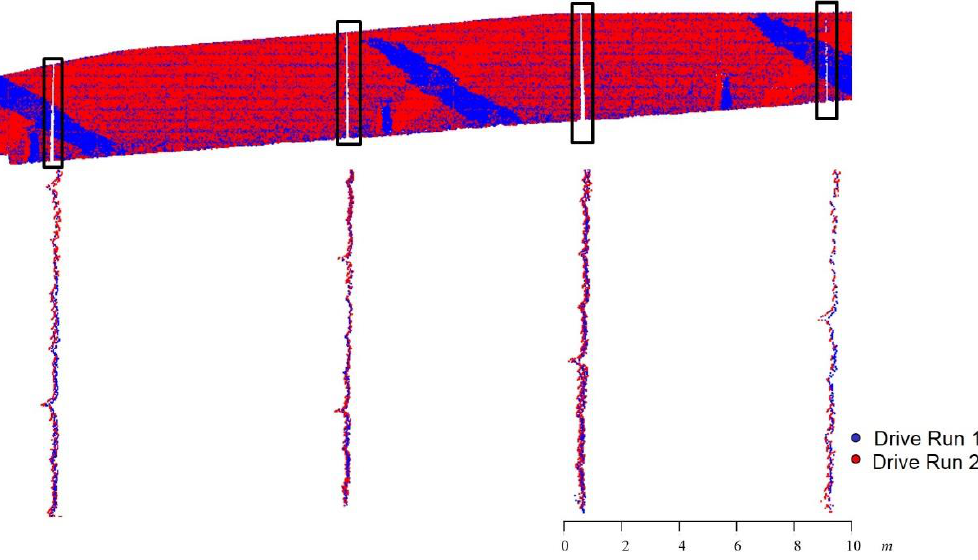
Figure 21. Cross sections illustrating the alignment quality of registered point clouds from the two MLS drive runs for the MSE wall at Site-1.